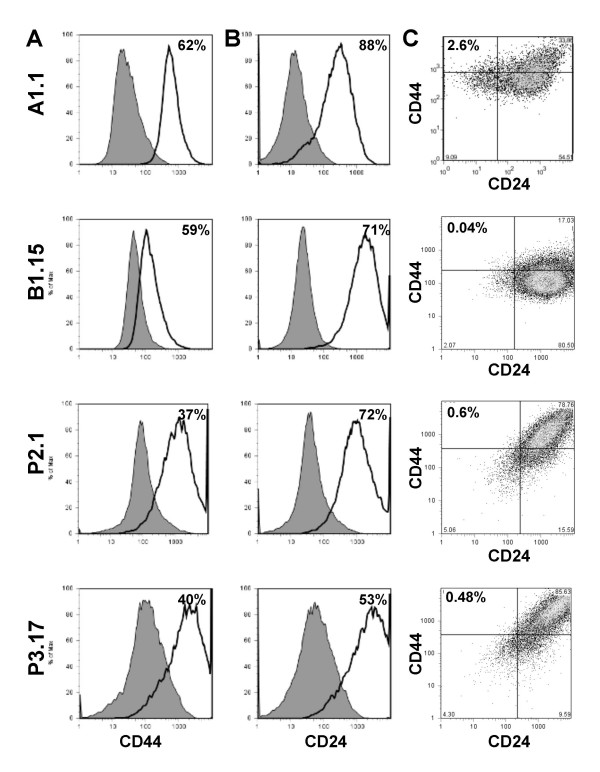
Characterization of cancer stem cell markers in Brca1 cell lines. Cell lines A1.1, B1.15, P2.1 and P3.17 were stained with fluorescently-conjugated mAb specific to CD44 (A), or CD24 (B), in parallel with isotype control-matched mAb and analyzed by flow cytometry. In the histograms shown, the thick black line represents positive staining and the gray filled lines represent the isotype control-matched mAb. (C) Bivariate plots represent the double staining of cell lines with fluorescently-conjugated CD44 and CD24 mAb. The quadrants are gated based on isotype controls and separate the double positive, single positive, and double negative populations. The percent of positive fraction for single label and CD44+/CD24- cells after compensation are indicated in each panel.